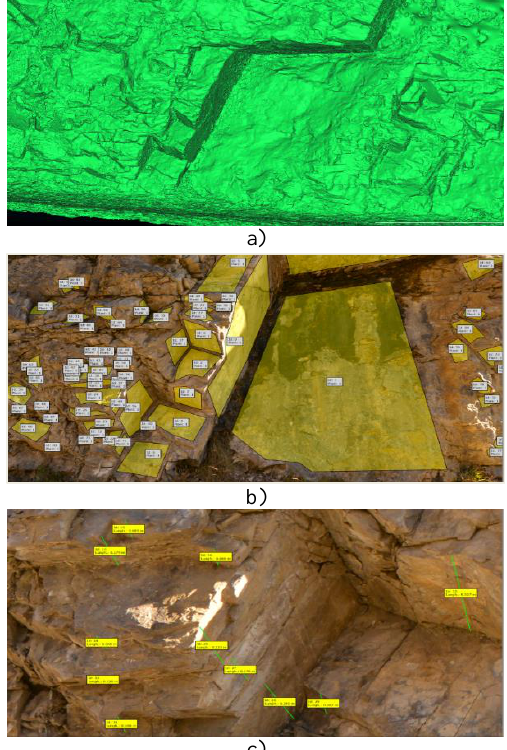
Figure 11.Geometrical features of discontinues collected by Rockscan software: a) Model; b) discontinuity planes; c)